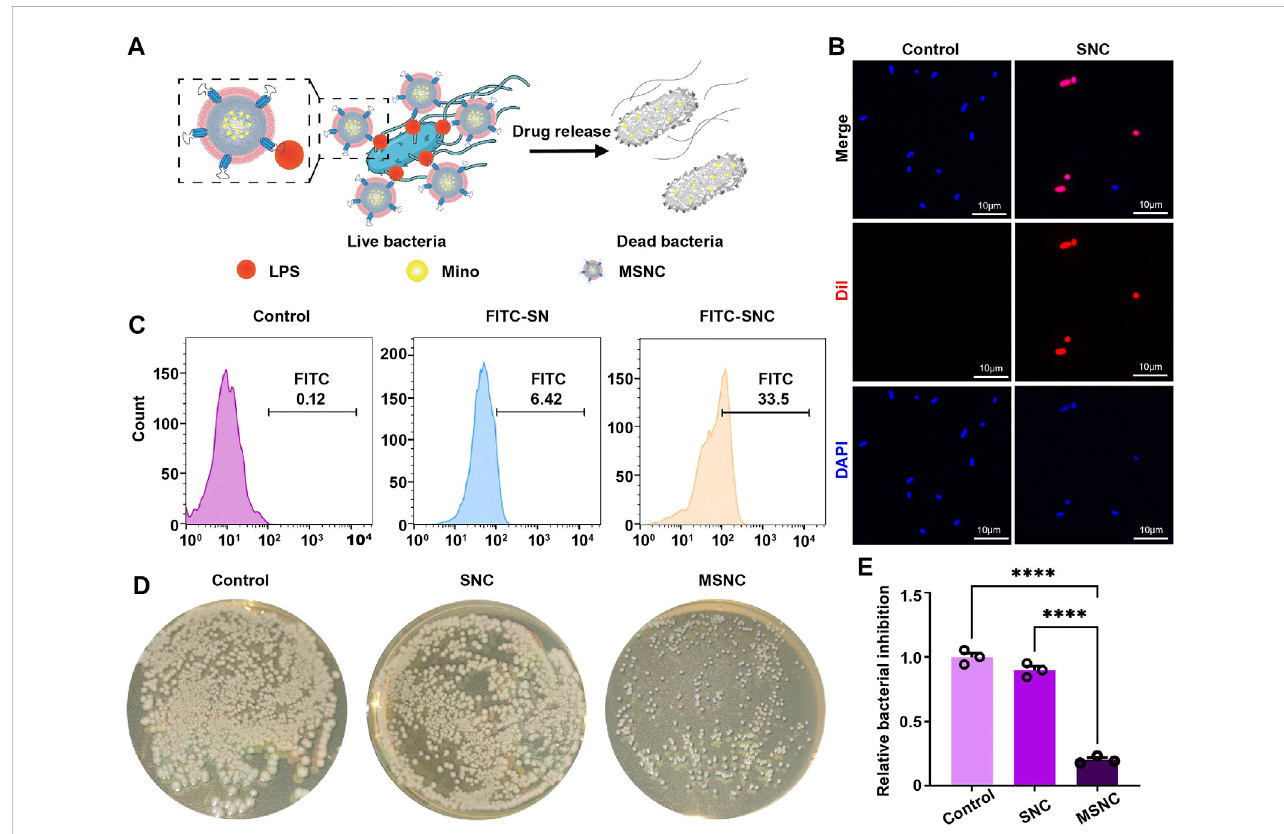
FIGURE 4 Targeting antibacterial effect of functioned cell membrane coated silk fi broin nanoparticles loaded with minocycline hydrochloride. (A) Schematic illustration of MSNCs targeting antibacterial effects. (B) Probing bacterial targeting using Dil-labeled cell membranes of SNCs with DAPI-labeled bacteria by laser confocal microscopy. (C) Probing bacterial targeting using FITC-labeling of SNCs by fl ow cytometry. (D) The antibacterial effect of MSNCs on E. coli in agar plates. (E) Quantitative analysis of the number of bacteria on agar plates. Data are presented as means ± SEM, *** p < 0.001, and **** p < 0.0001; by one-way analysis of variance (ANOVA) with Tukey ’ s post hoc test (E)